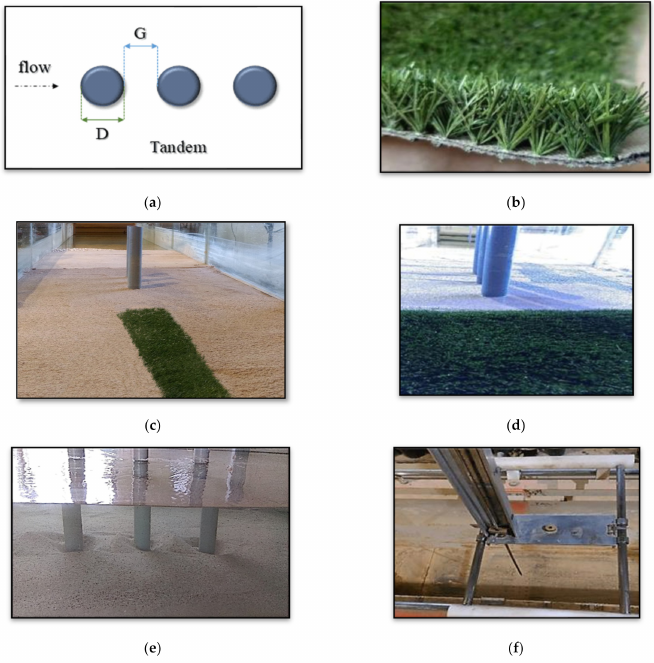
Figure 4. Experiment design. ( a ) The arrangement of the piles, ( b ) vegetation used (2 cm height), ( c ) patched vegetation, ( d ) overall vegetation, ( e ) scouring hole, ( f )